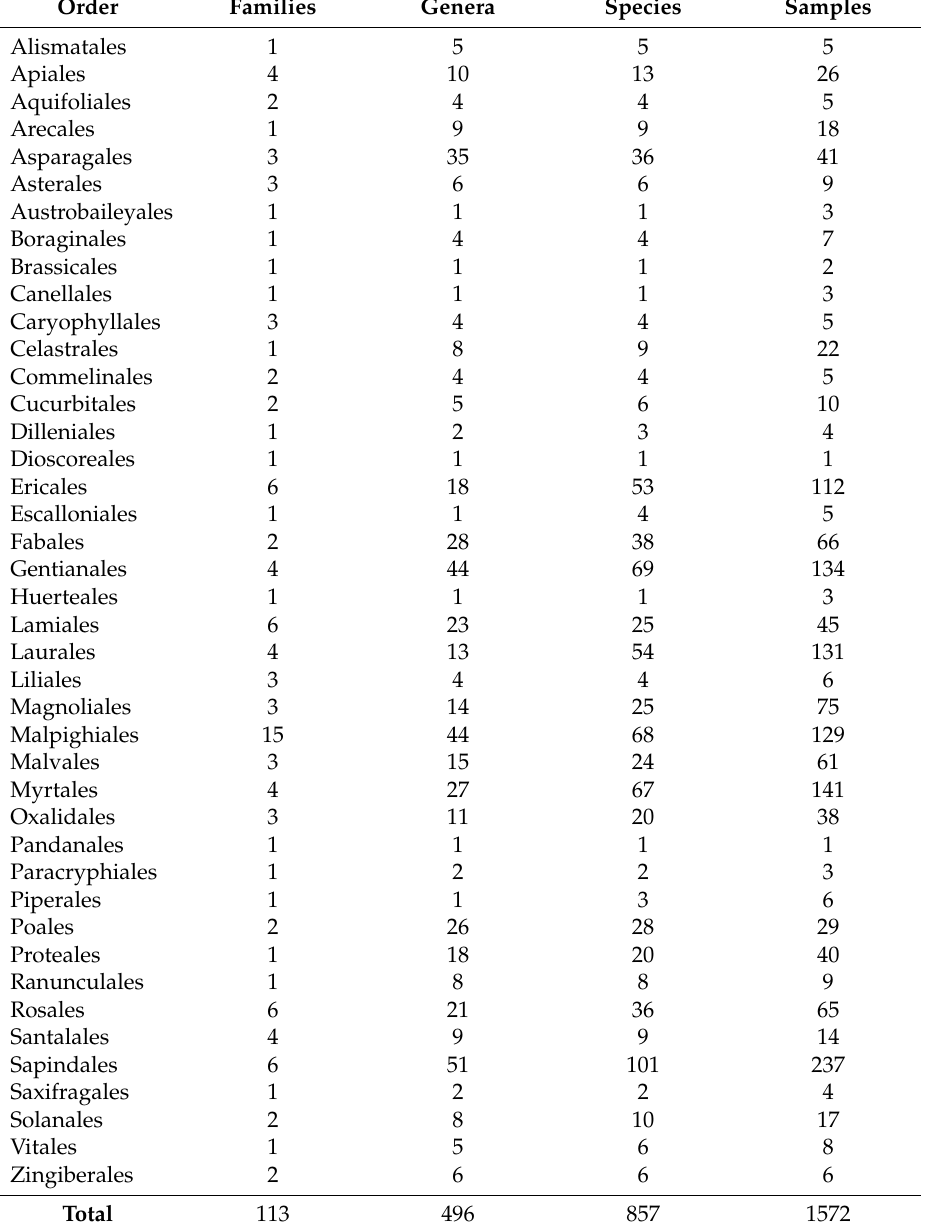
Table 1. Taxonomic distribution of angiosperm species in the BATF library listed alphabetically by order with total number of families, genera, species, and samples. Taxonomy follows APG